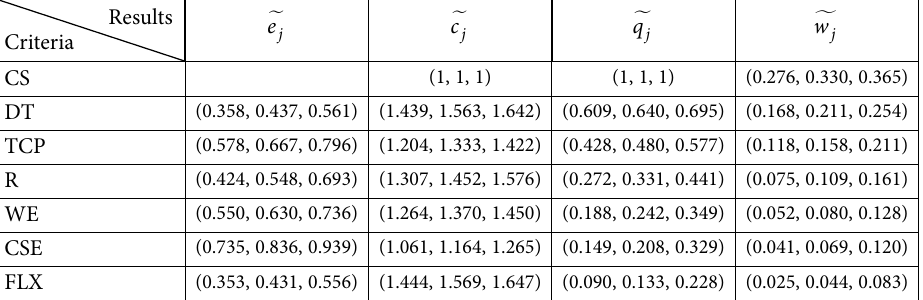
Table 6. The results of fuzzy